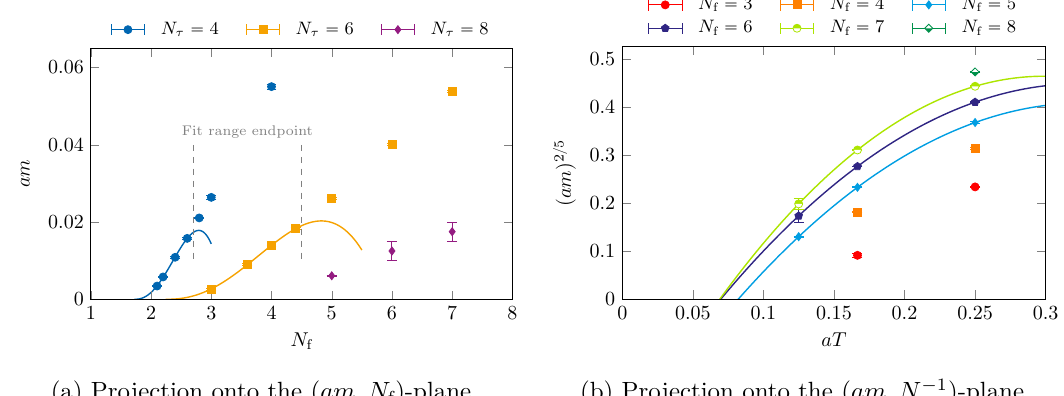
(a) Projection onto the ( am, N f ) -plane. (b) Projection onto the ( am, N − 1 Figure 7. The chiral critical surface projected onto different planes. Every point represents a phase boundary with an implicitly tuned β c ( am, N f , N τ ) . Lines in (a) represent next-to-leading order scaling fits to eq. (4.4) as in table 3. Solid lines in (b) are the analogue of the solid line in figure 8(b); refer to section 4.3 for more